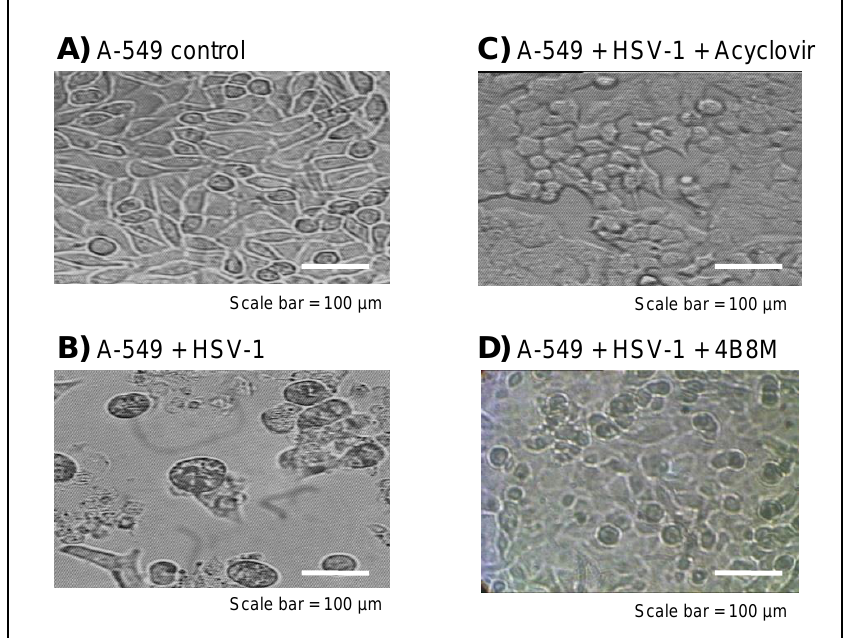
Figure 7. Microscopic evaluation of protective action of 4B8M against HSV-1 and its morphological changes in the A-549 cells. The photographs show 48 h cultures of A-549 cells infected with the HSV-1 virus (magnification 300 × ). ( A ) Photograph shows a normal appearance of the control culture of A-549 cells in the culture medium; photographs B–D illustrate cells pretreated with the virus: ( B ) HSV-1 negative control after 48 h infection with HSV-1; A-549 cells show some morphological changes, such as loss of monolayer integrity, lyses, granulation, vacuolization in the cytoplasm; ( C ) A-549 cells infected with HSV-1 in the presence of Acyclovir (22 µ g/mL); ( D ) A549 cells after 48 h co-incubation with HSV-1 and the peptide (25 µg/mL).